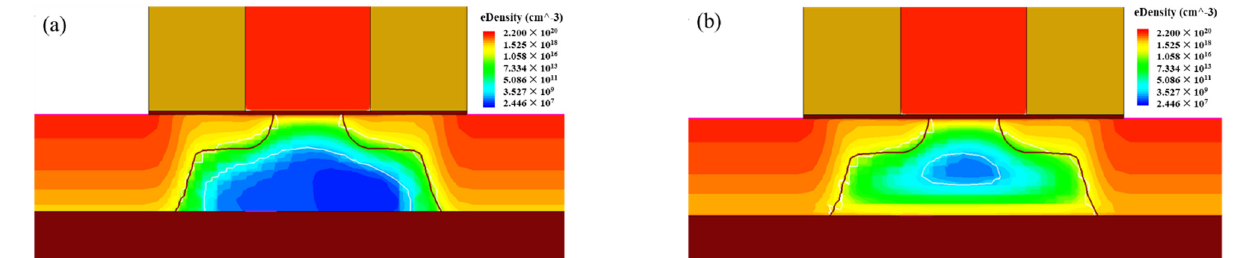
Figure 8. Simulation of channel electron number density in PDSOI device. ( a ) before irradiation, ( b ) after irradiation.